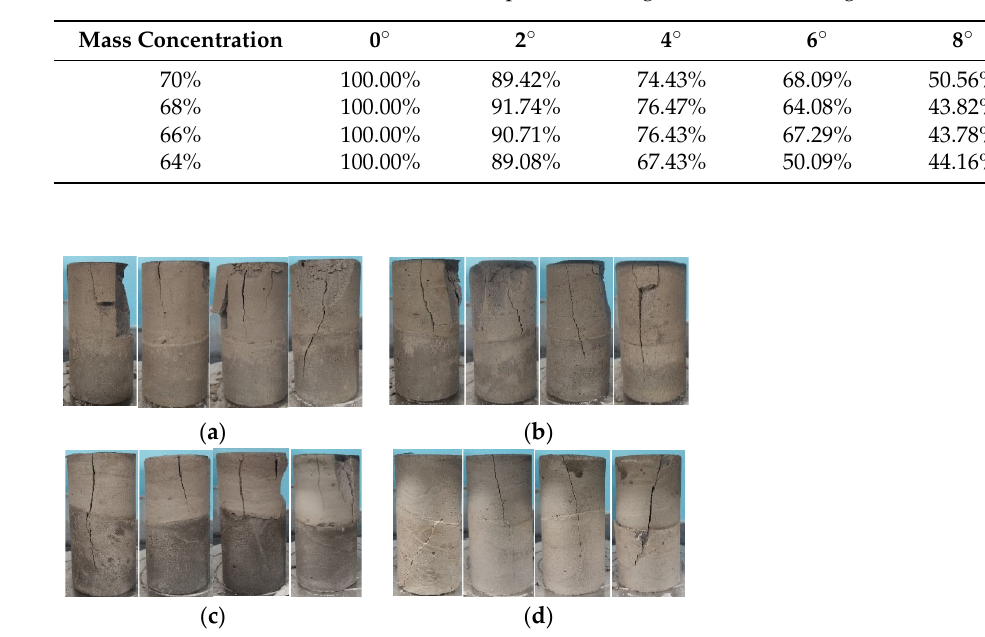
Table 6. Reduction coefficient of uniaxial compressive strength of inclined slicing backfill.